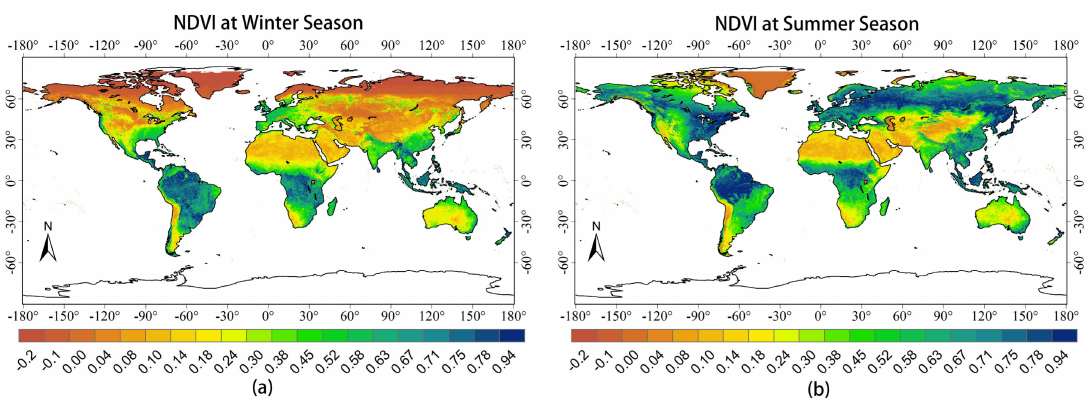
Figure 9. Global distribution map of seasonal averaged NDVI from MODIS; ( a ) Seasonal averaged NDVI during the winter season of the northern hemisphere (DJF); ( b ) Seasonal averaged NDVI during the summer season of the northern hemisphere